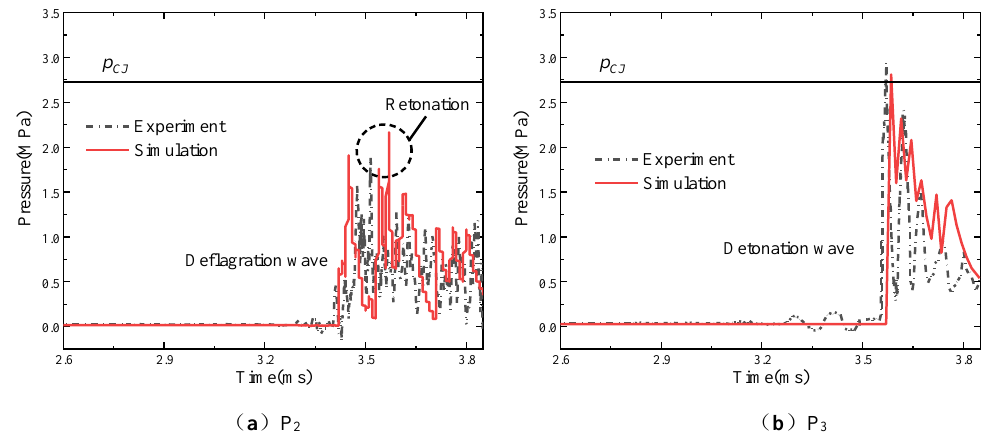
Figure 4. Pressure curves of experiment and numerical simulation.